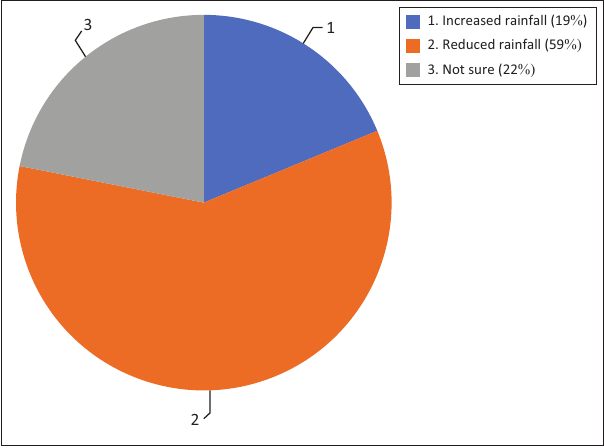
FIGURE 5: Perceptions of temperature changes ( n = 67). FIGURE 6: Perceptions of climate change impact on rainfall pattern.